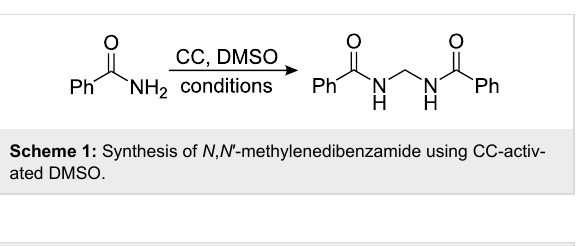
Table 1: Optimization studies for the synthesis of N , N ′-methylene- dibenzamide using CC-activated DMSO a . Entry